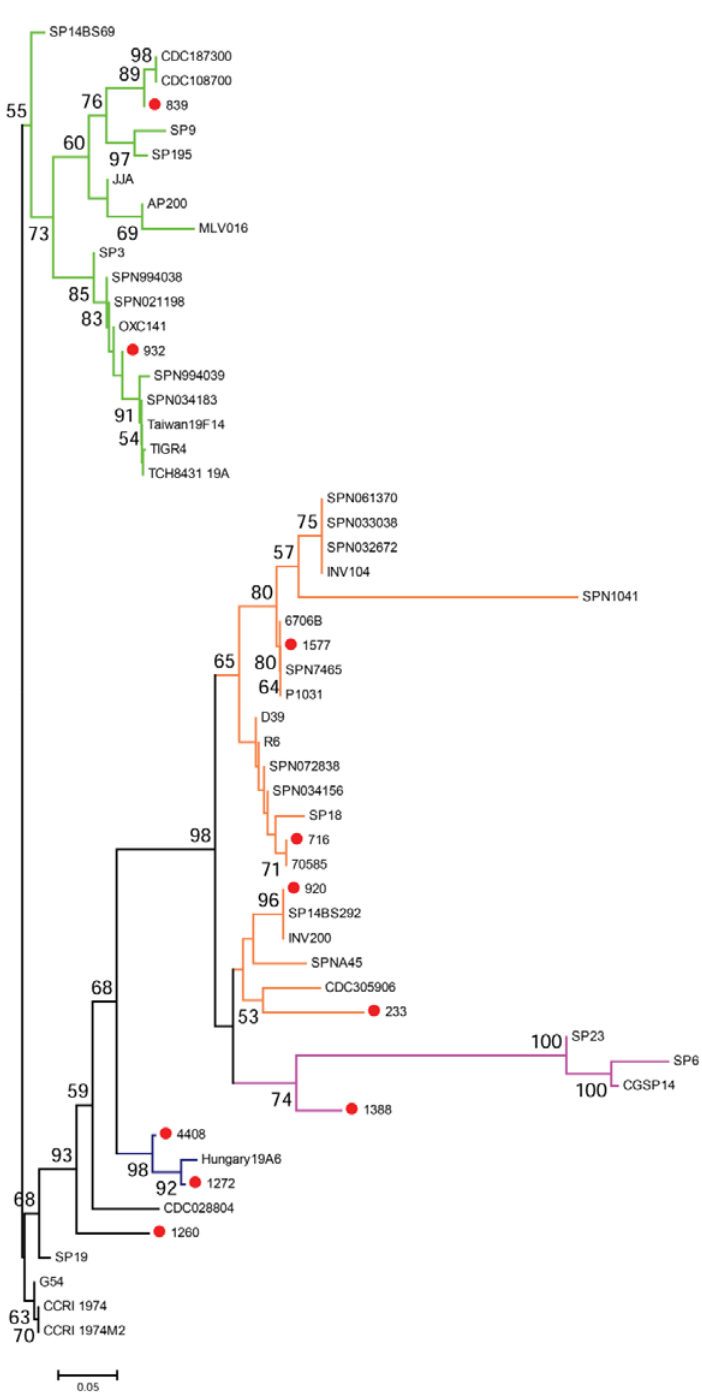
Figure A2. Maximum likelihood phylogenetic tree of the PRR sequences of 10 S. pneumoniae clinical isolates (marked with a red dot) and of 44 S. pneumoniae genomes from the NCBI database using a general time-reversible (GTR) substitution model with (cid:5) correction for among-site rate variation. The branches are annotated with their bootstrap support (numbers in the branch). Marked pneumococcal clinical isolates were tested for their cross-reactivity with serum IgG antibodies induced upon immunization with epitope-loaded SVLPs. Colored branches correspond to pspA allelic variants that have been classified into clades according to Hollingshead SK et al. [30], green: clade 3; orange: clade 1; pink: clade 2; blue: clade 5; black: clade